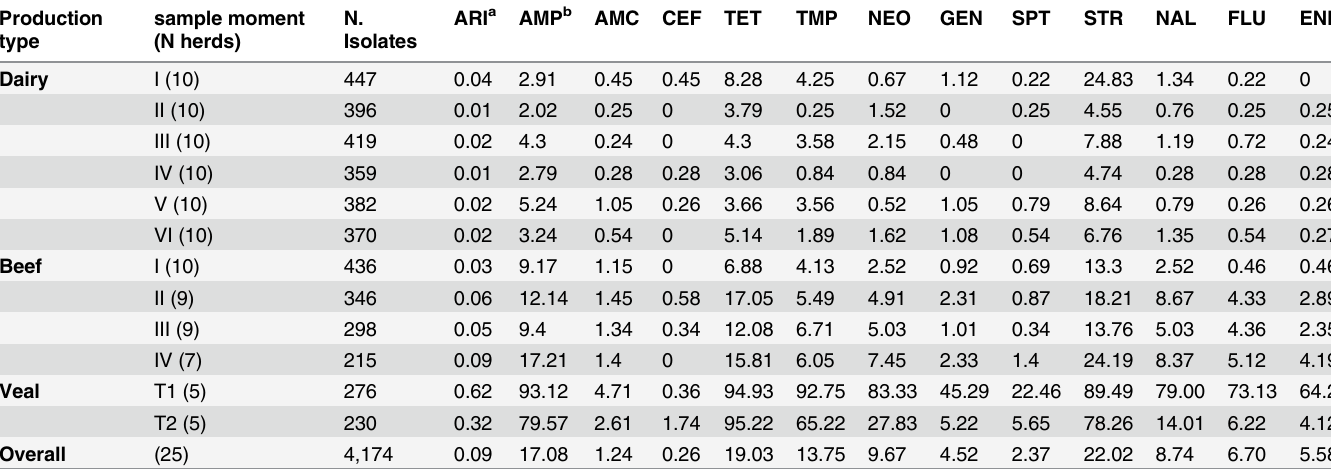
Table 5. Overview of resistance percentages of E . coli during the consecutive sampling periods on the different production types. Production sample moment type (N herds)